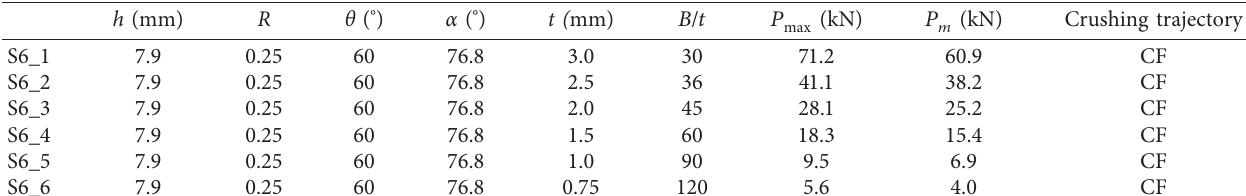
Table 3: Geometries and numerical results of the square prefolded tubes with various thicknesses.